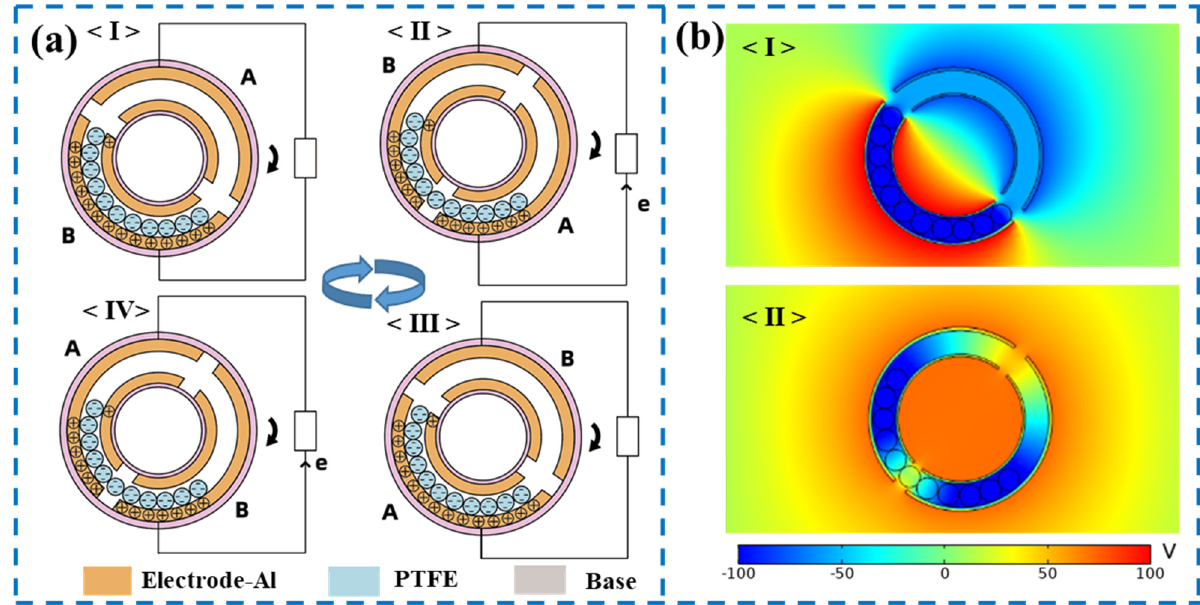
Figure 2. Working mechanism of the R-TENG: ( a ) schematic illustration of the working mechanism of the R-TENG; ( I ) cylinders fully overlapping electrode B; ( II ) cylinders getting in touch with electrode A; ( III ) cylinders fully overlapping electrode A; ( IV ) cylinders getting in touch with electrode B; ( b ) electrical potential distributions at different positions using COMSOL Multiphysics; ( I ) cylinders fully overlapping one electrode; ( II ) equivalent charge induced on two electrodes.